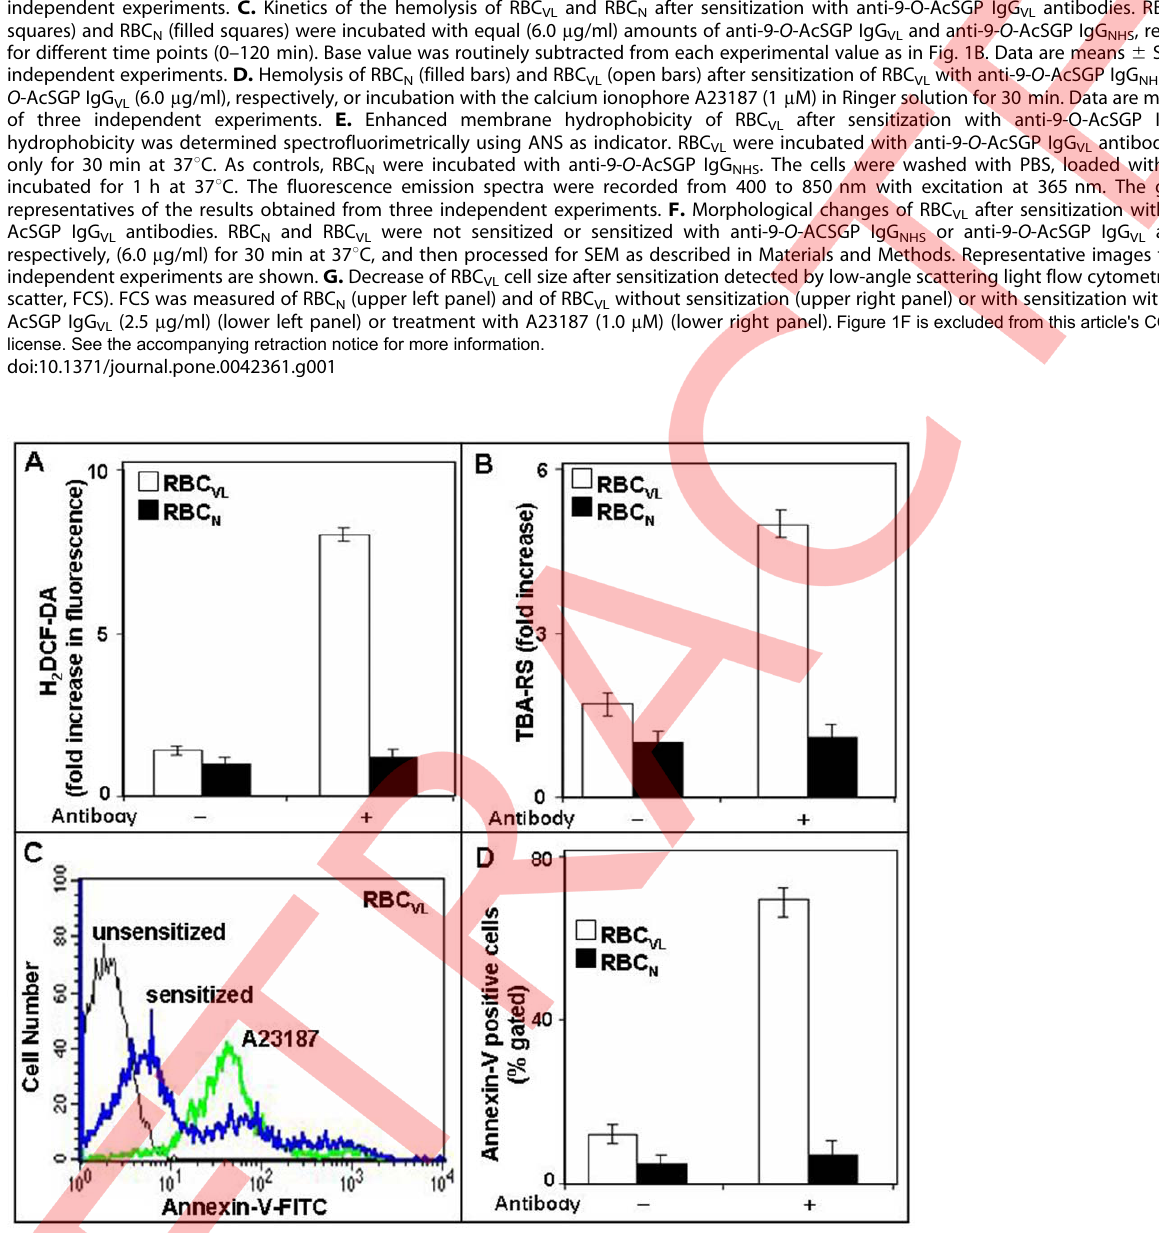
Figure 2. Enhanced ROS, lipid peroxidation and externalization of phosphatidyl serine (PS) in RBC VL after sensitization with anti-9- O -AcSGP IgG VL . A . Induction of ROS in sensitized RBC VL . Prior to sensitization with anti-9- O -AcSGP IgG VL or anti-9- O -AcSGP IgG NHS RBC VL and RBC N were incubated with the hydroperoxide indicator H 2 DCF-DA in PBS for 30 min at 37 u C. Then the antibodies were added, the cell incubated as before and ROS generation determined by fluorimetry. As controls, ROS generation was determined after prior treatment of the RBC with N -acetyl cysteine, a quencher of hydroperoxides. The results are expressed as means 6 S.D. (n=5) of fold increases in comparison to the fluorescence levels detected with untreated erythrocytes. B. Increased lipid peroxidation in sensitized RBC VL . Lipid peroxidation of erythrocyte membrane was detected and quantified with thiobarbituric acid (TBA) and the TBA-reactive species (TBA-RS) measured with a spectrophotometer at 532 nm. The results are mean 6 S.D of fold increase in comparison with unsensitized RBC of five independent measurments. C–D. Enhanced externalization of phosphatidylserine on sensitized RBC VL . Sensitized or unsensitized erythrocytes were incubated in annexin-V binding buffer with FITC-annexin-V and analyzed by flow cytometry. A23187-treated RBC in the presence of Ca 2 + served as positive control. The results are shown as representative histogram of three independent experiments ( C ) and as comparative flow-cytometric analysis ( D ).